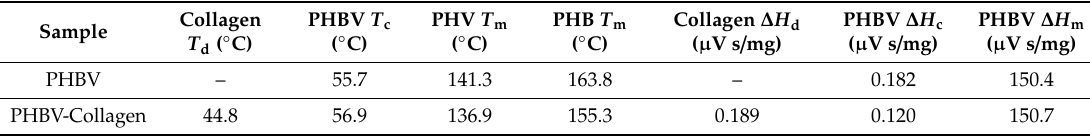
Figure 5. DSC thermograms of PHBV and PHBV-Collagen membranes. Figure 6. (A) Change in PHBV contact angle with collagen conjugation. (B) % Change in Mass in Table 1. Summary of main peaks and the respective enthalpies of DSC thermal transitions for PHBV conjugated and unconjugated fibres over 6 weeks of incubation at physiological conditions (*p<0.05, ns, no-significant). and